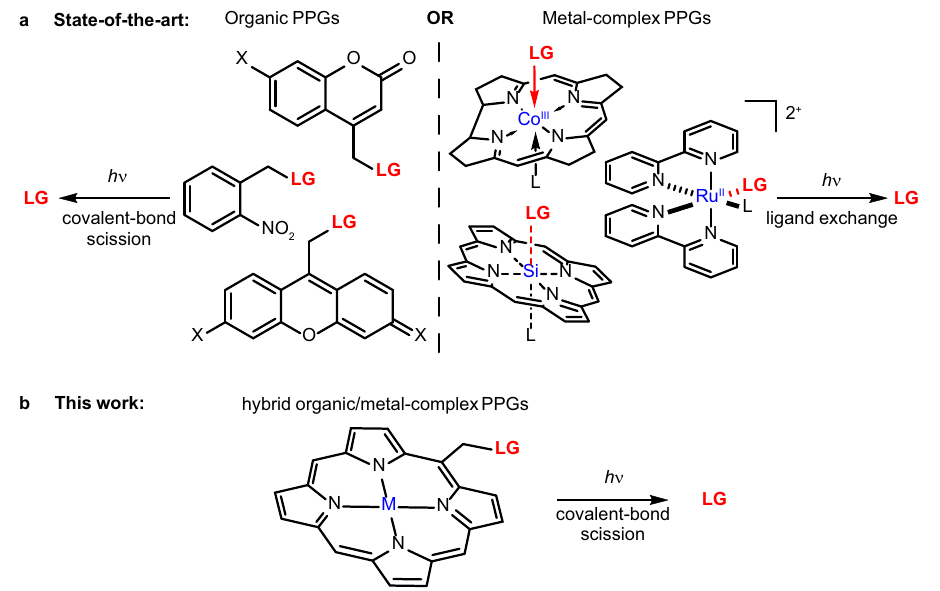
Fig. 1 Meso -methylporphyrin as a hybrid organic/metal-complex PPG scaffold. a Contemporary organic and metal-complex PPGs; the photorelease of leaving groups (LG) occurs via a covalent bond scission or ligand exchange process, respectively. b Meso -methylporphyrin as a hybrid organic/metal- complex PPG: diverse metal ions can be incorporated into the chromophore to modulate its properties, and a leaving group is photoreleased via covalent bond